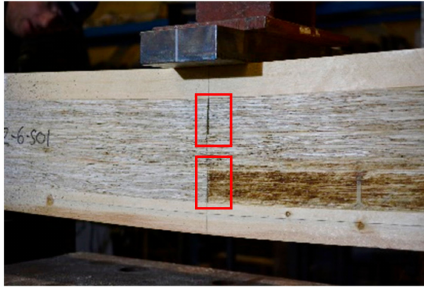
Figure 2. A 5-A1a beam specimen with butt joints in the second and fourth